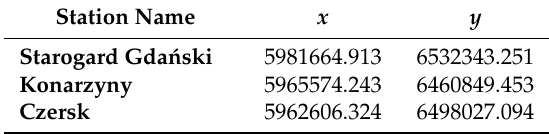
Table 3. Coordinates of the SmartNet network reference